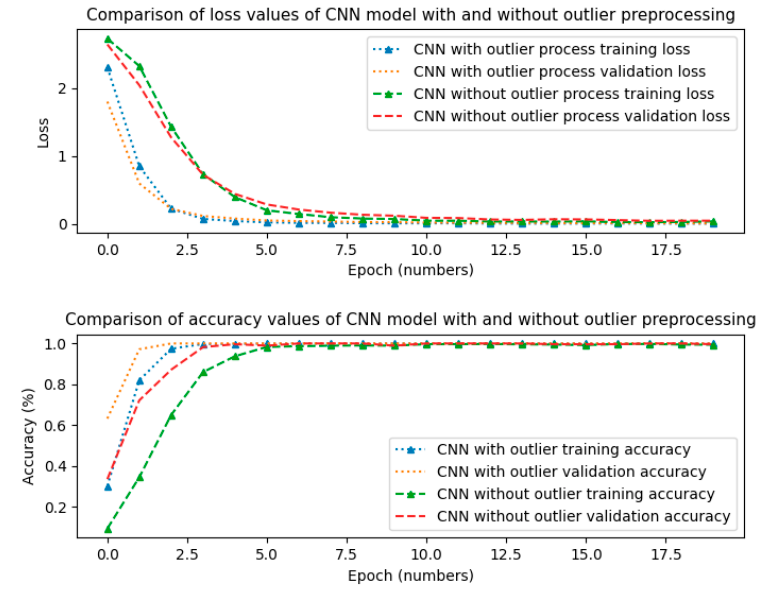
Figure 10. Comparison of performance of 1D CNN model using datasets with and without outlier values. lier values.